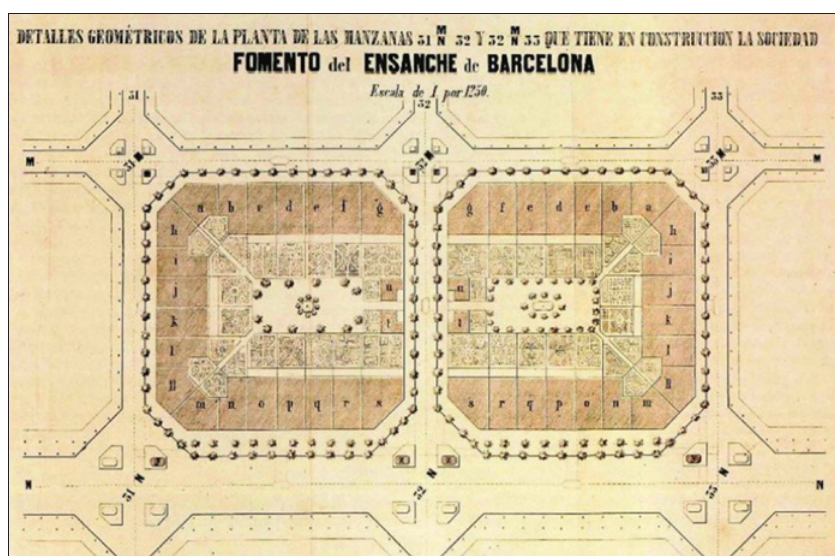
Figure 3: Three-sided manzanas with a central public green space as originally drawn by Cerda. This is one of the originally proposed detailed layouts for the square street blocks shown in Figure 2. The large courtyards allowed adequate ventilation, sunlight and natural daylight. They provided a pleasant living environment for the inhabitants of the 20